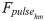
The reward-growth function.Gallistel and colleagues have shown that the pulse frequency is translated into the intensity of the rewarding effect by a saturating function [21–23, 28], such as a logistic [33] (Eq S11). We assume that in those experiments, the induced firing frequency can be equated to the pulse frequency [8]. The position of the growth curve along the X axis is determined by the pulse frequency that drives reward intensity to half its maximal value (Fhm, also called Fpulsehm below), whereas the position along the Y axis (e.g., the maximal reward intensity attained) is determined by a parameter we call Krg. In the left panel, Fhm is varied while Krg is held constant, whereas in the right panel, Krg is varied while Fhm is held constant. The inserts are described below, after the reward mountain has been introduced. The pulse frequencies shown here are typical of eICSS experiments.